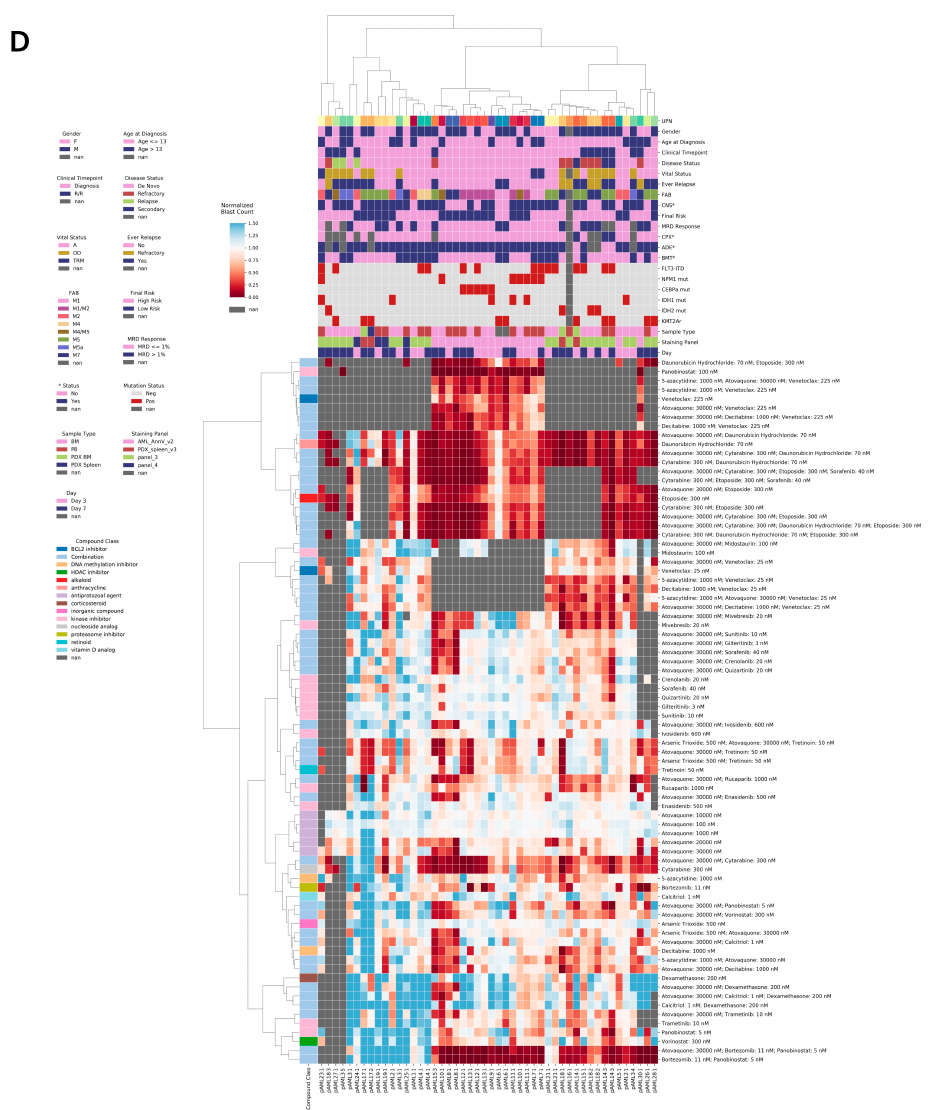
Figure 1 . Ex vivo drug sensitivity profiling for 31 pediatric AML patients. ( A ) Fresh blood or bone marrow aspirate samples were collected for this study prior to treatment on day 0, and/or at the end of induction (EOI), from 31 pediatric AML patients diagnosed at Texas Children’s Hospital. Twenty- seven patients received cytarabine, daunorubicin, and etoposide (ADE) as backbone chemotherapy, and four patients did not receive an ADE backbone. ( B ) Patients were stratified by induction chemotherapy, disease status, pre-treatment sample collection, and matching ex vivo data. R/R, relapsed or refractory. ( C ) Ex vivo drug sensitivity was profiled using an automated flow cytometry-based platform. RBC, red blood cell. ( D ) Heat map of ex vivo drug sensitivity results that passed the data quality control, including 48 total samples from 27 pediatric AML patients (columns) in response to 78 dose conditions (rows). Patients were clustered based on differential ex vivo drug sensitivity using hierarchical clustering (Euclidean distance metric, Ward linkage criterion). Cell color indicates normalized blast counts <1 (red; reduction in blasts) or normalized blast counts >= 1 (blue; no or low reduction in blasts). Rows above the heat map indicate selected clinical and biologic variables. UPN, unique patient number; F, female; M, male; R/R, relapse/refractory; A, alive; DD, died of disease; TRM, treatment related mortality; CNS, central nervous system; FAB, French–American–British; BM, bone marrow; PB, peripheral blood; PDX, patient-derived xenograft mouse model; MRD, minimal residual disease; CPX, CPX-351; BMT, bone marrow transplant; Day, readout day for ex vivo drug sensitivity; * status for CPX, ADE, BMT; nan, not